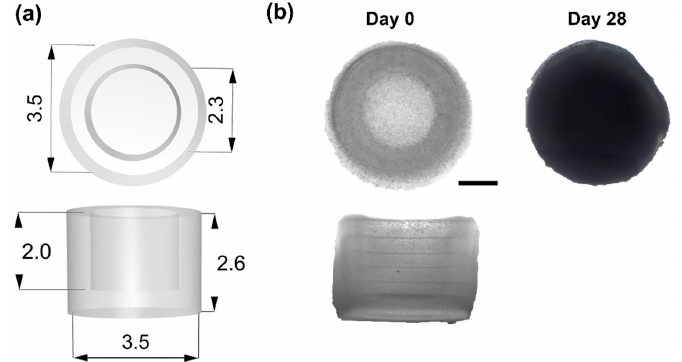
Figure A2. Bioprinting of a scaled-up construct containing P-MPCs. ( a ) CAD model of the bioprinted construct. Measurements are given in mm. ( b ) Microscopic images of bioprints on days 0 and 28 of cultivation. Scale bar = 1000 µm.